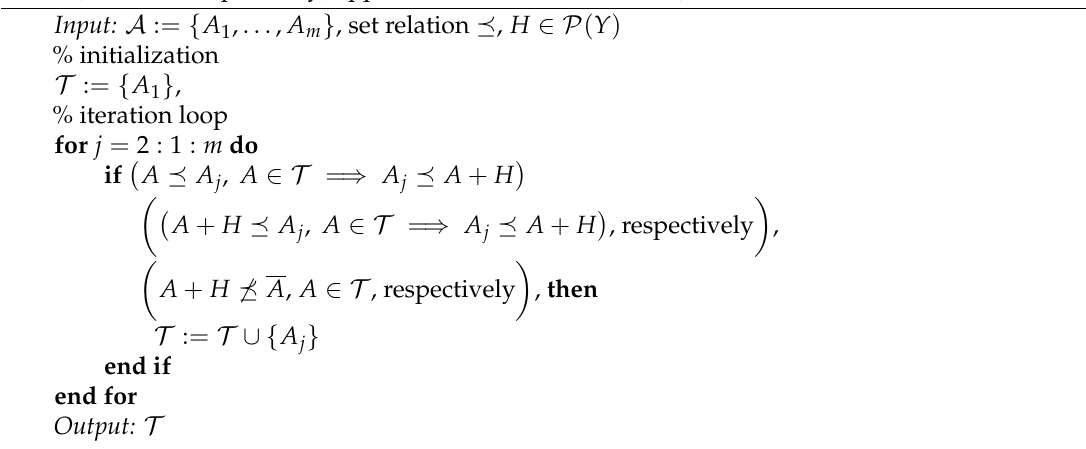
Algorithm 1: (Method for sorting out elements of a family of finitely many sets which are not H 1 - ( H 2 -, H 3 -, respectively) approximate minimal